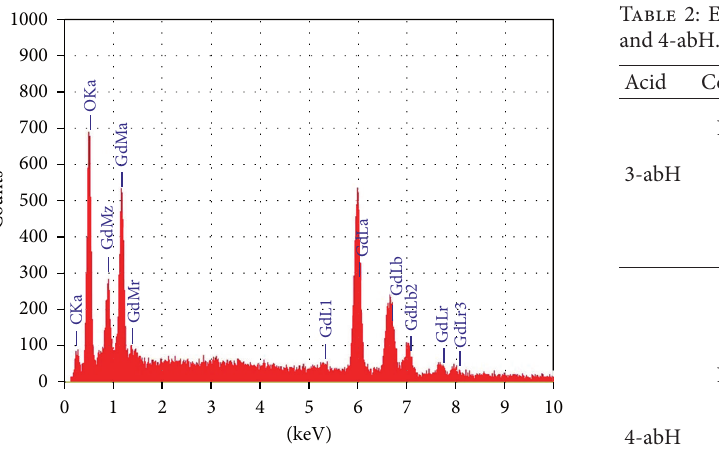
F 8: SEM-EDX image of Gd